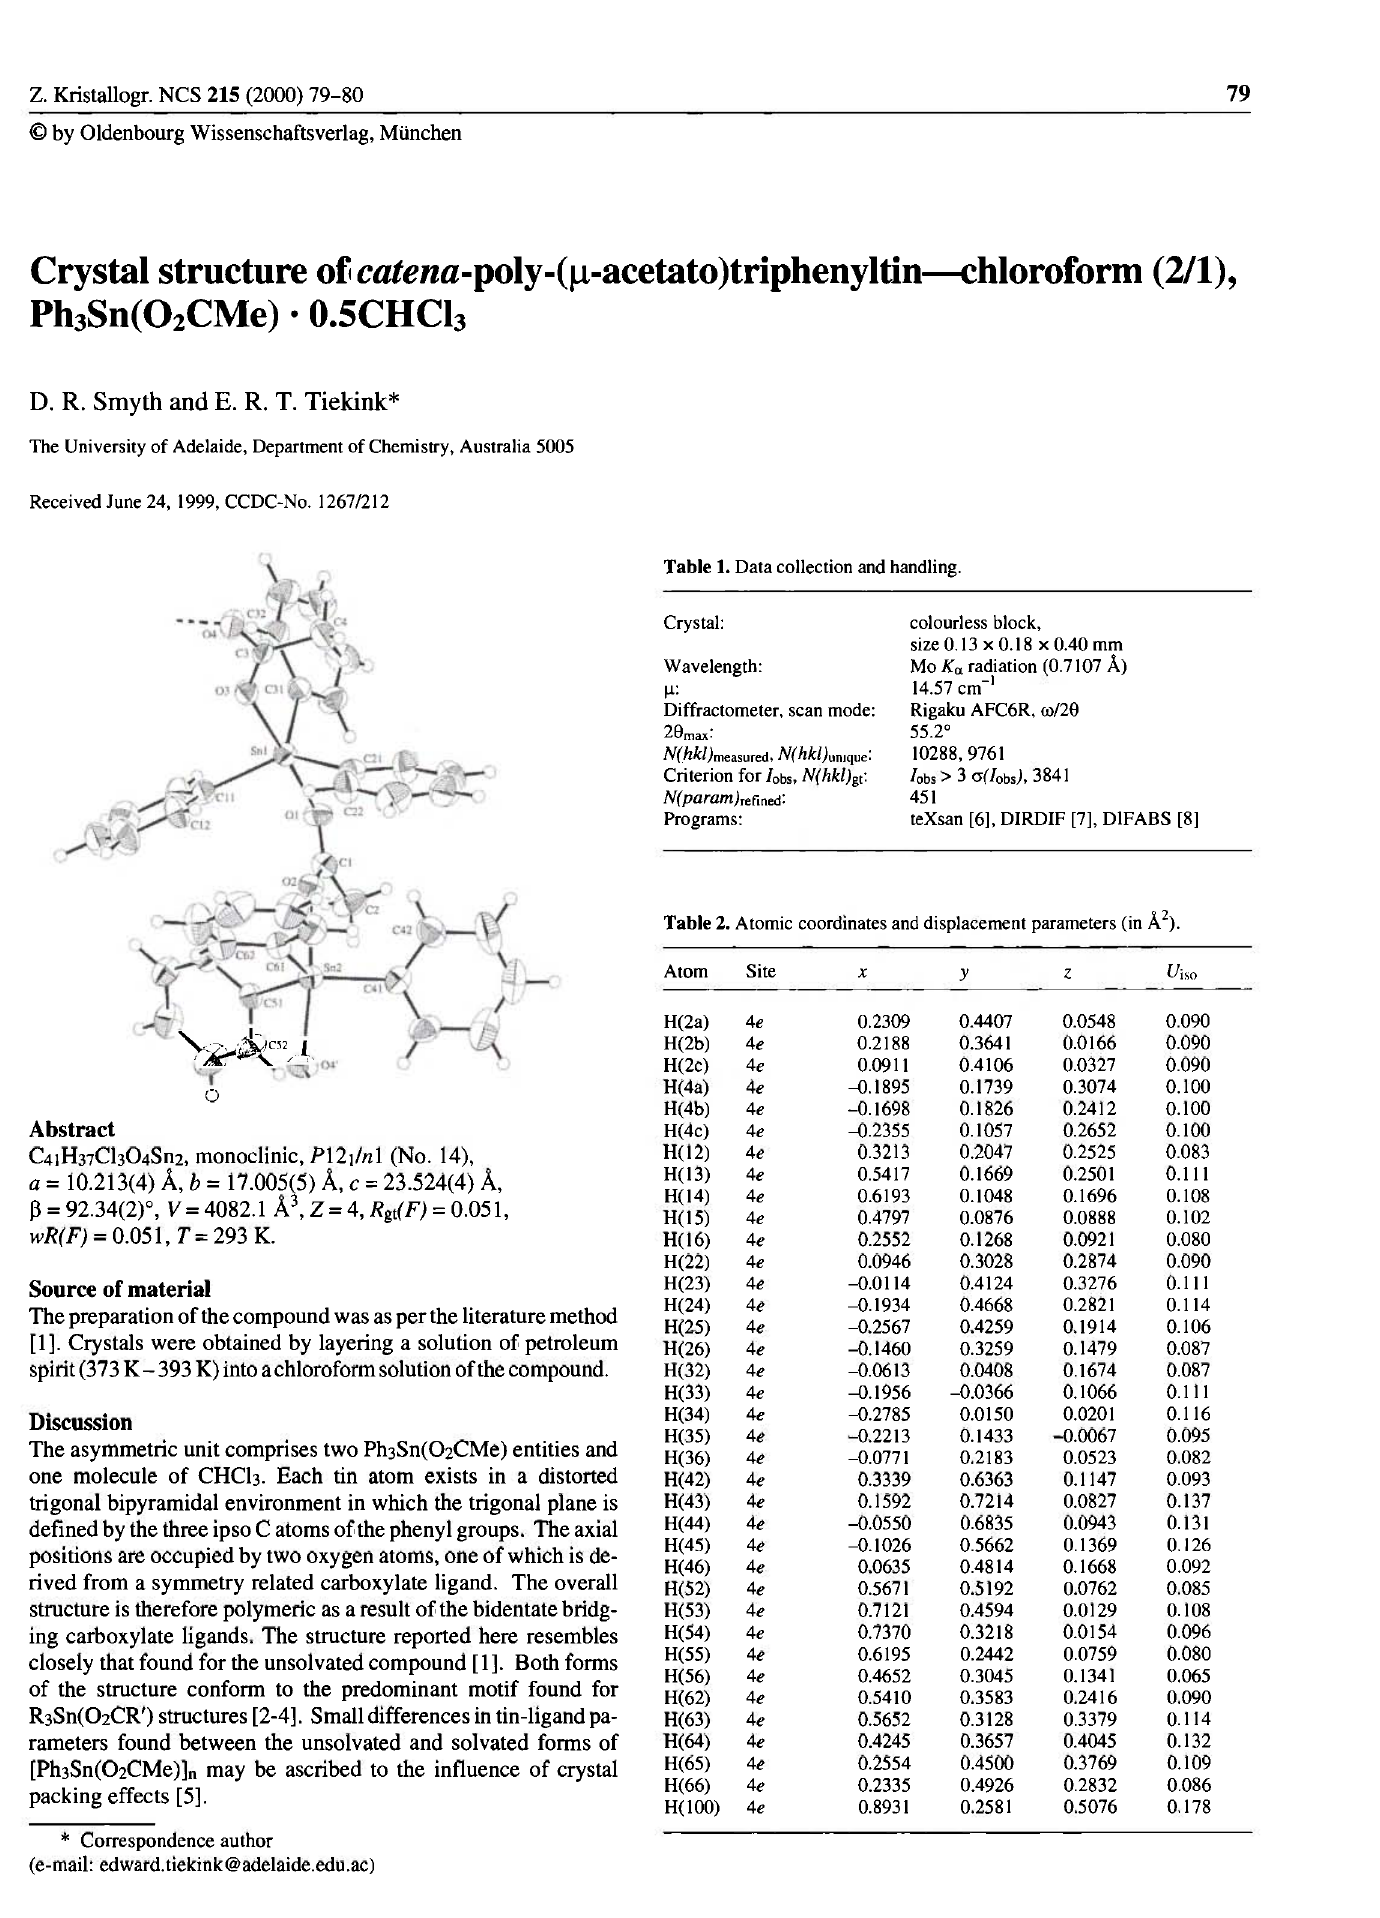
Table 1. Data collection and handling.